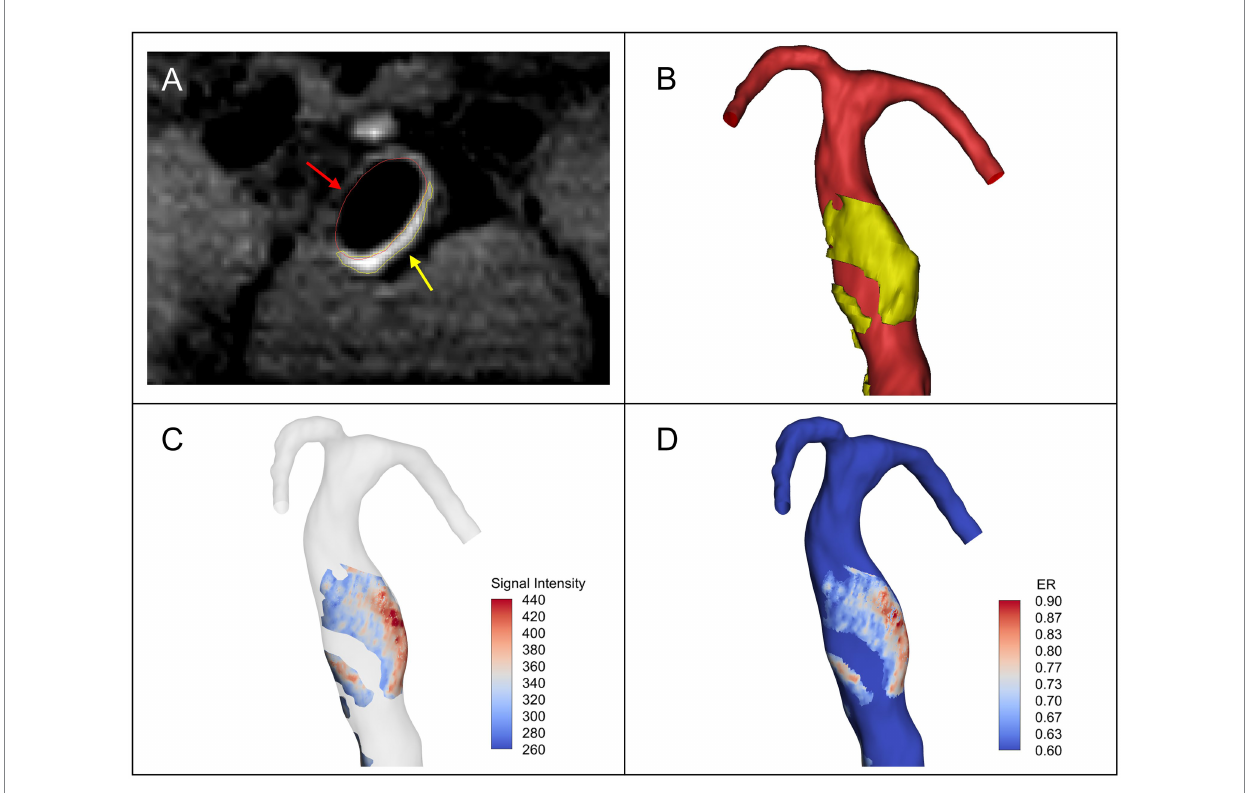
FIGURE 1 (A) The vascular lumen region (red arrow) and the AWE region (yellow arrow) segmented in the registered post-contrast high-resolution magnetic resonance imaging (HR-MRI). (B) Vascular model (red) and 3D model of the aneurysm wall enhancement (AWE) region (yellow). (C) The signal intensity of AWE was projected onto the vascular model to identify enhanced regions on the surface of the model. (D) The enhancement ratio (ER) was calculated by normalizing the signal intensity value of AWE at each point on the model surface with the maximum signal intensity value of pituitary